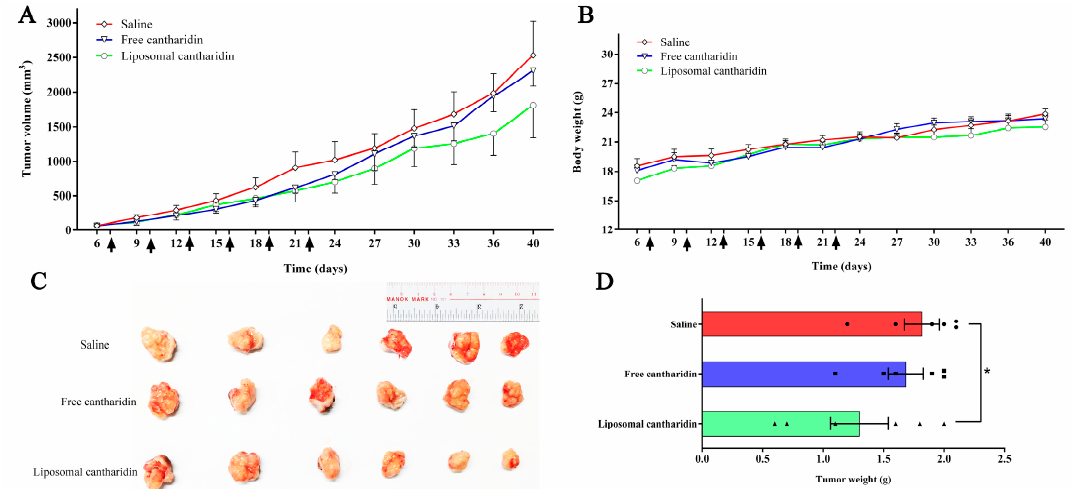
Figure 5. Anticancer efficacy of cantharidin and liposomal cantharidin on HepG2-tumor bearing nude mice in vivo. ( A ) Tumor volume profiles of nude mice in different treatment groups ( n = 6, mean ± SEM). Mice were administrated with saline, free cantharidin and liposomal cantharidin at a cantharidin dose of 0.35 mg/kg for six intravenous injections in total at three-day intervals. ( B ) Body weights of mice were monitored during the whole experiment periods ( n = 6, mean ± SEM). ( C ) After 42 days, tumors in different groups were excised and photographed. ( D ) The tumor weight was recorded at the end of the experiments on 42 days. Liposomal cantharidin showed significant lower tumor weights compared to control group ( n = 6, means ± SEM). * p < 0.05 compared to the control.